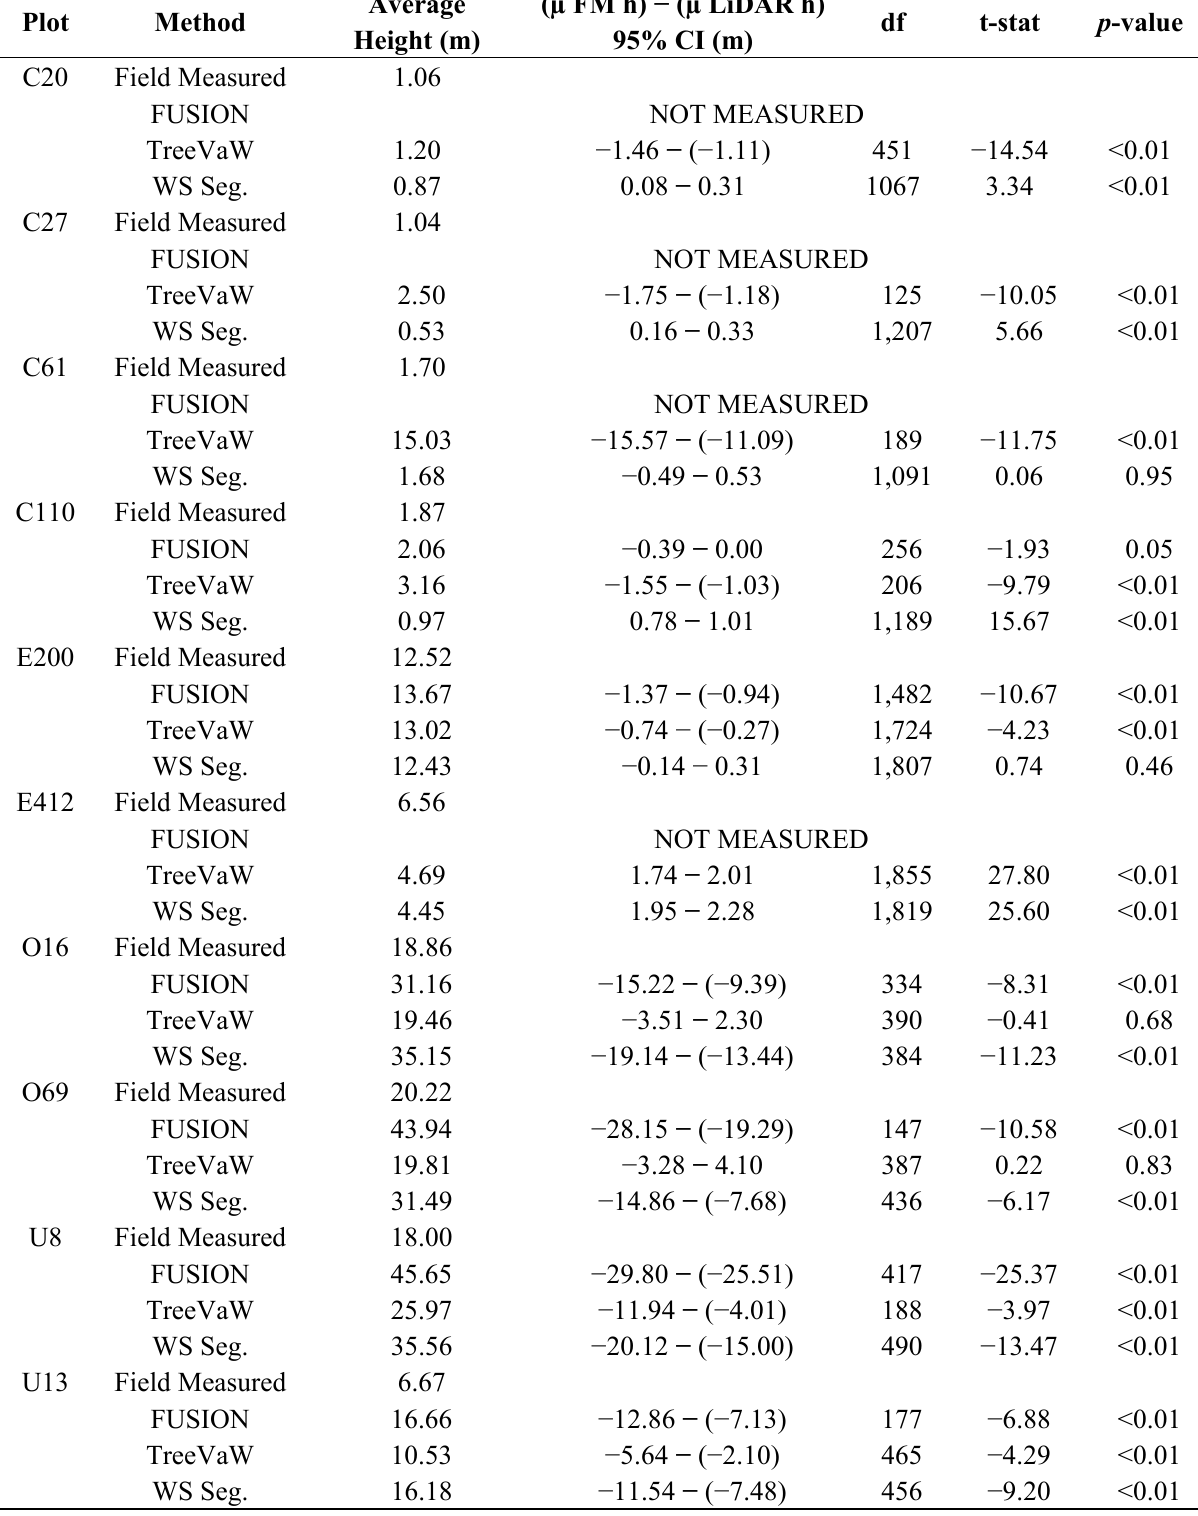
Table 12. Statistical comparison of mean LiDAR tree heights (h) to field measured (FM) tree heights as measured by a laser range